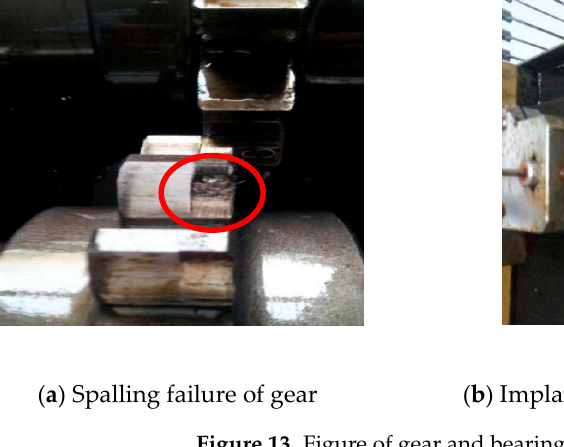
Figure 13. Figure of gear and bearing outer ring fault.